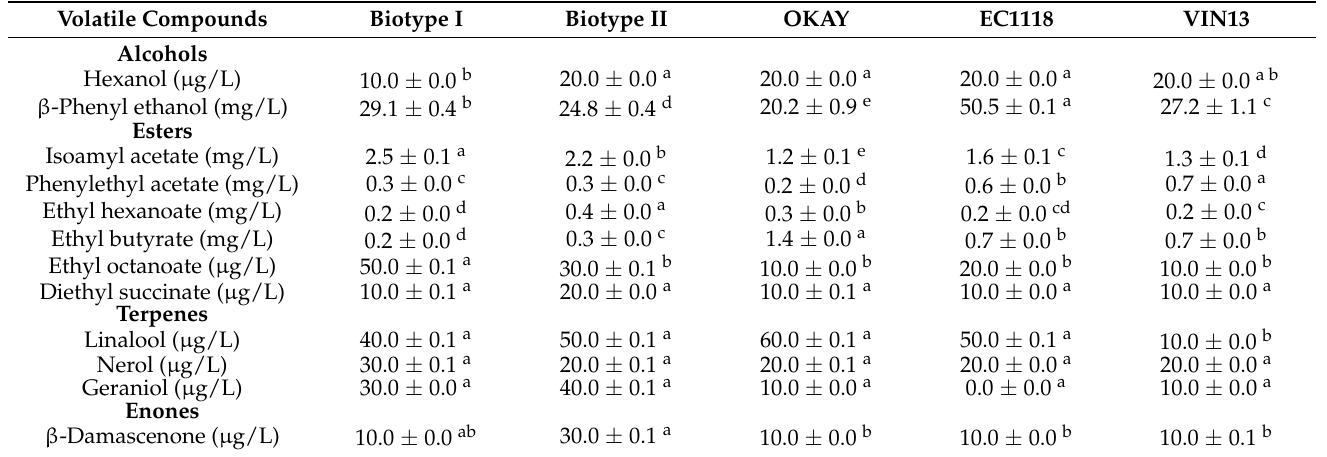
Table 5. Main volatile compounds of wines obtained by the two native S. cerevisiae strains compared with commercial starters, fermented at 16 ◦ C. Data are means ± standard deviations, and those with different superscript letters ( a–d ) within each row are significantly different, according to Duncan’s tests ( p -value < 0.05).